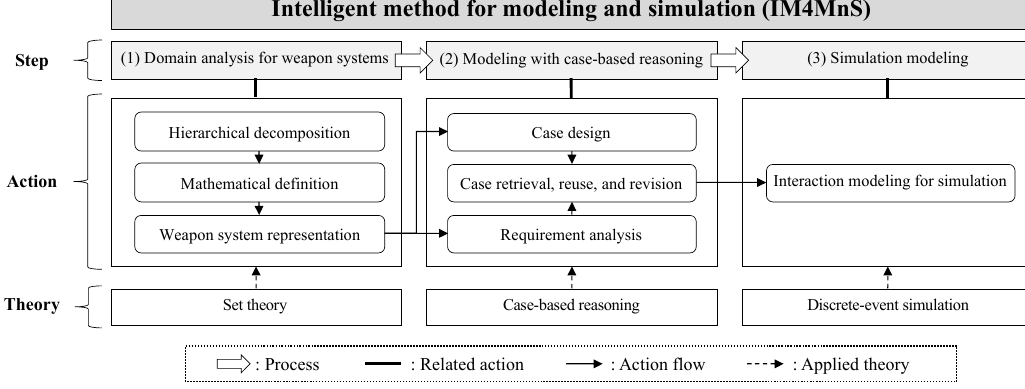
Figure 1. Overall concept of intelligent method for modeling and simulation.